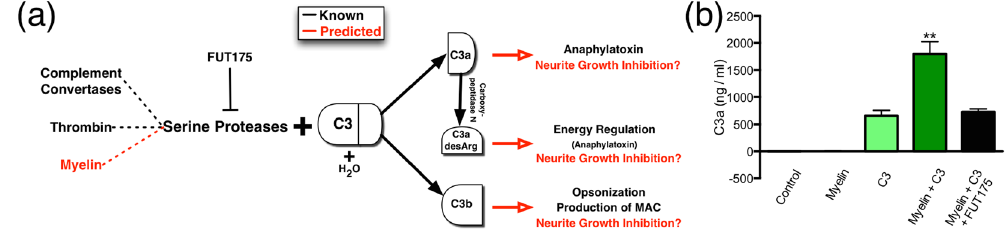
Figure 4. Complement C3 can be cleaved by a serine protease in myelin. ( a ) Diagram of C3 cleavage including tested hypotheses. Complement convertases are known serine proteases that cleave C3 into C3a and C3b, which are functionally active immune proteins; in turn, C3a is converted to C3a desArg by carboxypeptidase N. FUT-175 inhibits serine protease activity and prevents C3 cleavage. Spontaneous hydrolysis of C3 also occurs at a relatively low level generating C3bH 2 0. We predicted (in red) that serine proteases in myelin could cleave C3, and that newly formed active cleavage products (C3b, C3a, C3a desArg) may mediate neurite outgrowth inhibition and/or neuron death. These hypotheses are tested in Figs 4b and 5. ( b ) Results of C3a ELISA following incubation of C3 alone, C3 + myelin, and C3 + myelin + FUT-175. As expected, essentially no C3a was detected in control or myelin wells, and a small amount of C3a was detected with C3 alone. However, myelin significantly increased the generation of C3a, and this effect was blocked by FUT-175, indicating that serine proteases in myelin are capable of C3 cleavage. Mean ± SEM. *** p < 0.001 ANOVA, with ** p < 0.01 Dunnett’s post-hoc t-test vs. C3 alone. N = 2 biological replicates for per